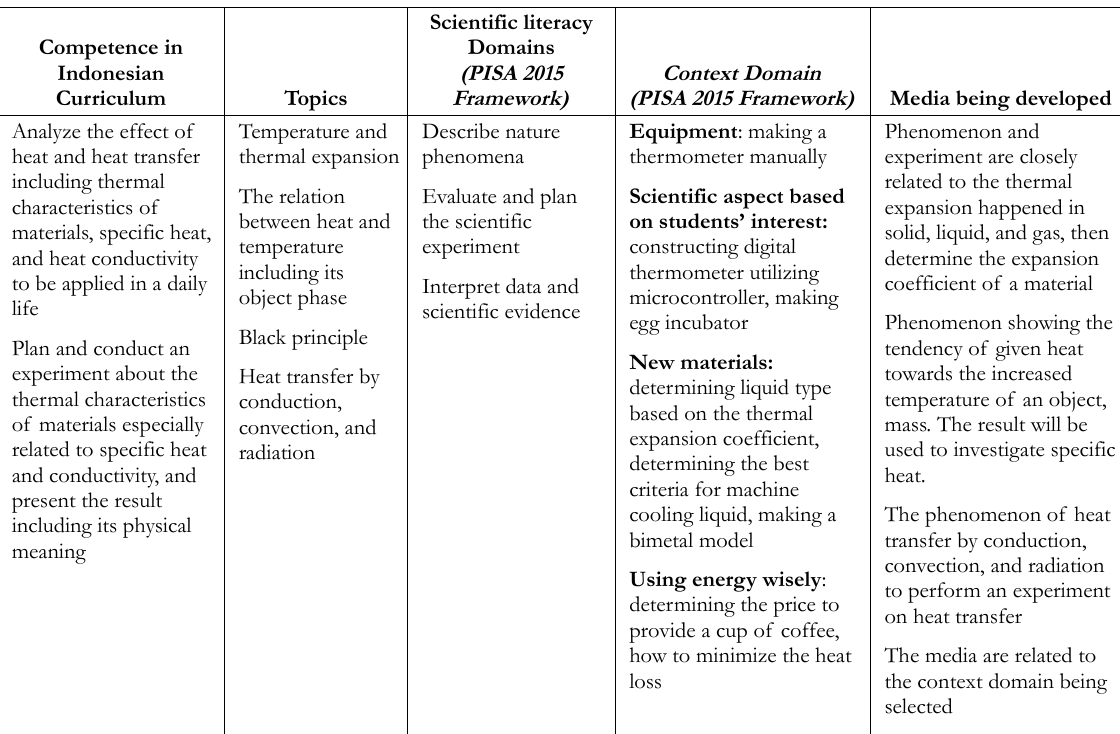
Table 1. Analysis of curriculum and scientific literacy framework 2015 in terms of heat and temperature